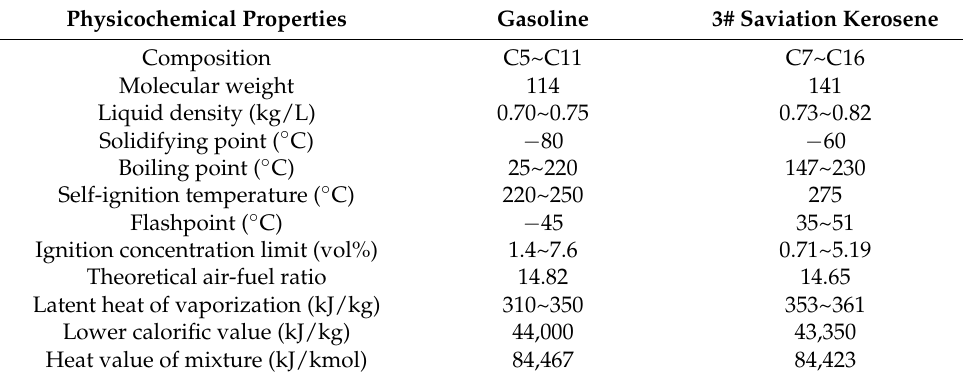
Table 2. Physicochemical properties of gasoline and 3 # aviation kerosene.